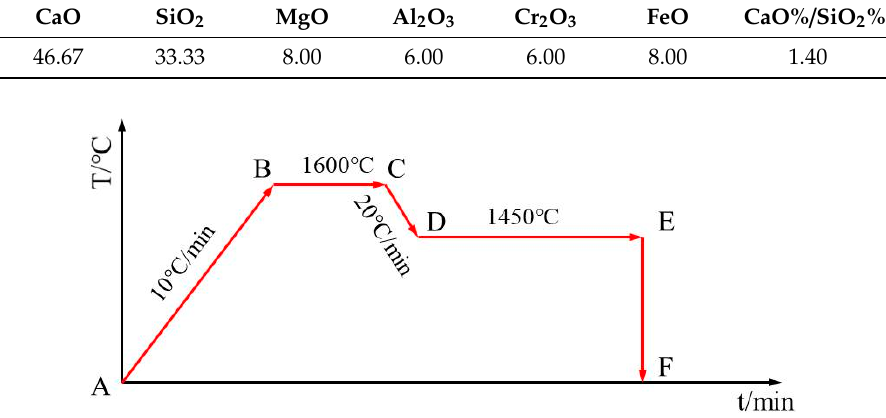
Table 1. The chemical composition of stainless-steel slag, g.